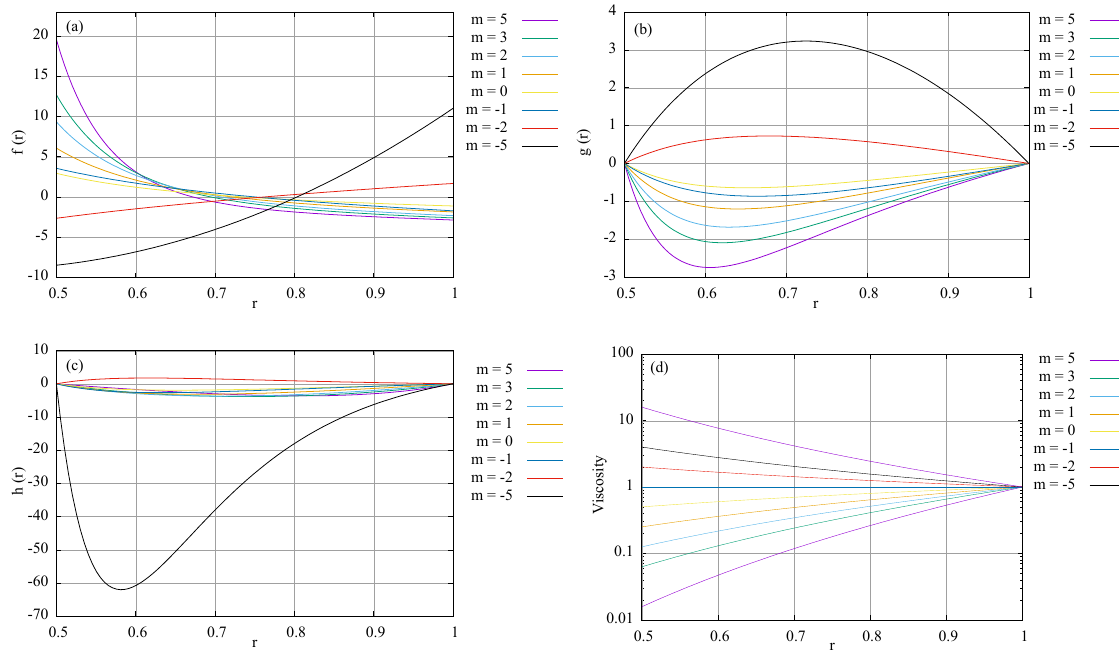
Figure 1. Functions f (r) (a) , g(r) (b) , h(r) (c) , and viscosity profile µ(r) (d) as a function of r ∈ [ 0 . 5 : 1 ] for various values of m